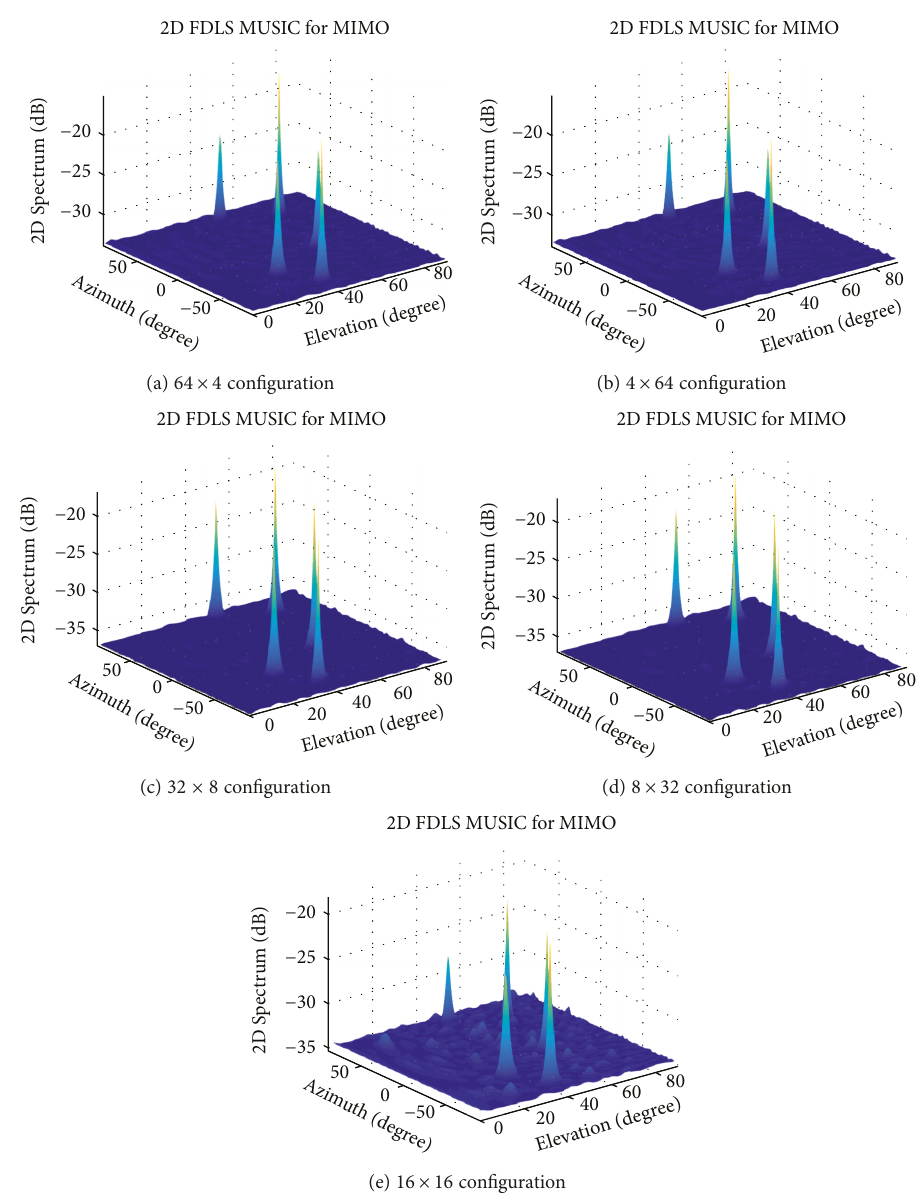
Figure 2: 2D FDLS MUSIC spectrum for MIMO in di ff erent antenna con fi